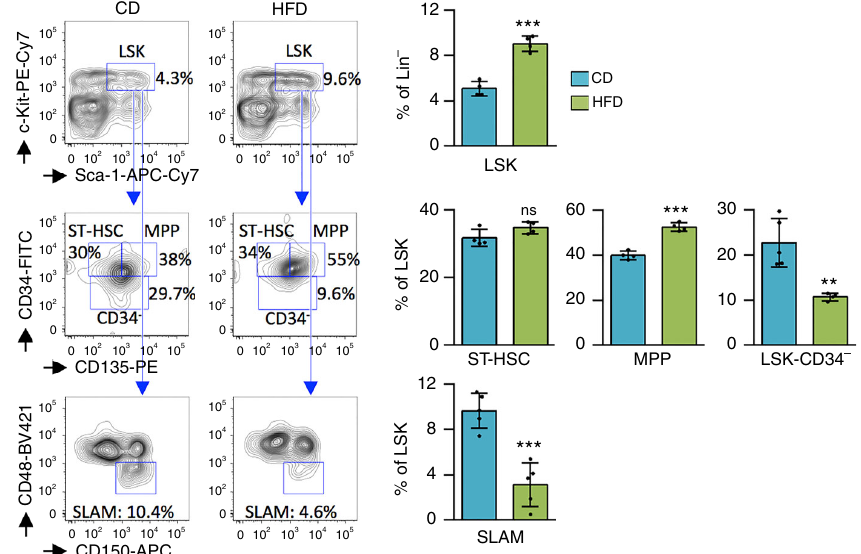
Fig. 3 Short-term HFD impairs maintenance of HSC. Lin − cells from 4-week HFD-fed mice are enriched in LSK cells and multipotent progenitors (MPP). HFD induced the loss of SLAM (CD150 + CD48 − ) HSC in BM. Data show mean ± SD (mice per diet group: n = 4 (CD) and n = 4 (HFD) for LSK, ST-HSC, and MPP; n = 5 (CD) and n = 4 (HFD) for LSK-CD34 − ; n = 5 (CD) and n = 5 (HFD) for SLAM); ns, non-signi fi cant ( P > 0.05); ** P < 0.01; *** P < 0.001 (two-tailed unpaired Student ’ s t -test) NATURE COMMUNICATIONS| (2019) 10:523